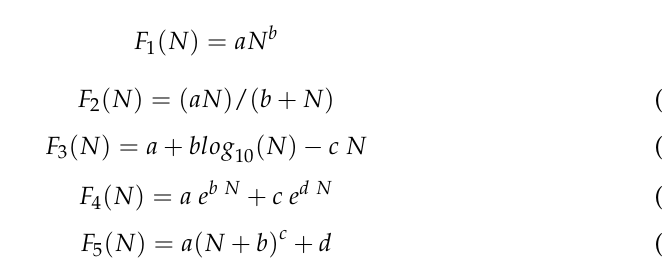
Table 2. Fitted functions’ parameters for Set 1 of hypervolume values.